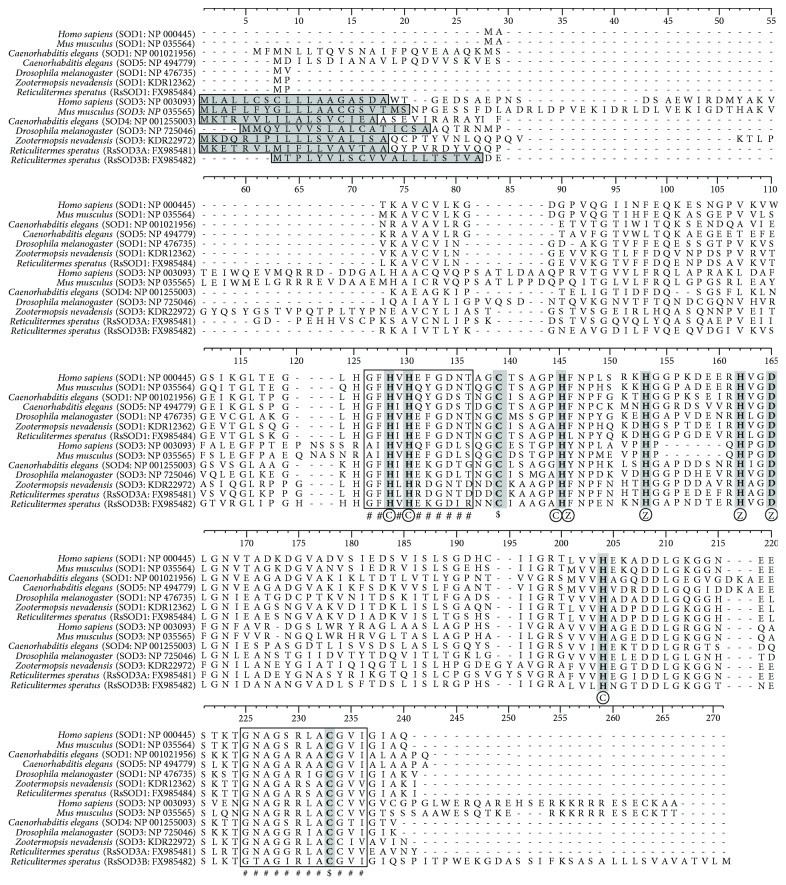
Alignment and structure conservation of Cu/Zn-SOD sequences. Multiple sequence alignment of Homo sapiens, Mus musculus, Caenorhabditis elegans, Drosophila melanogaster, Zootermopsis nevadensis, and Reticulitermes speratus. The signal cleavage site is indicated by a grey box. Conserved functional residues are highlighted in bold characters in grey (circled C = copper-binding site; circled Z = zinc-binding site; circled C, circled Z = copper- and zinc-binding sites; and $ = intrasubunit disulphide bridge site). SOD signature sequences are denoted in blocks with #.